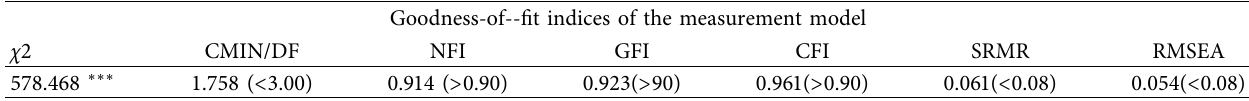
Table 5: Goodness-of-fit indices of the measurement model.